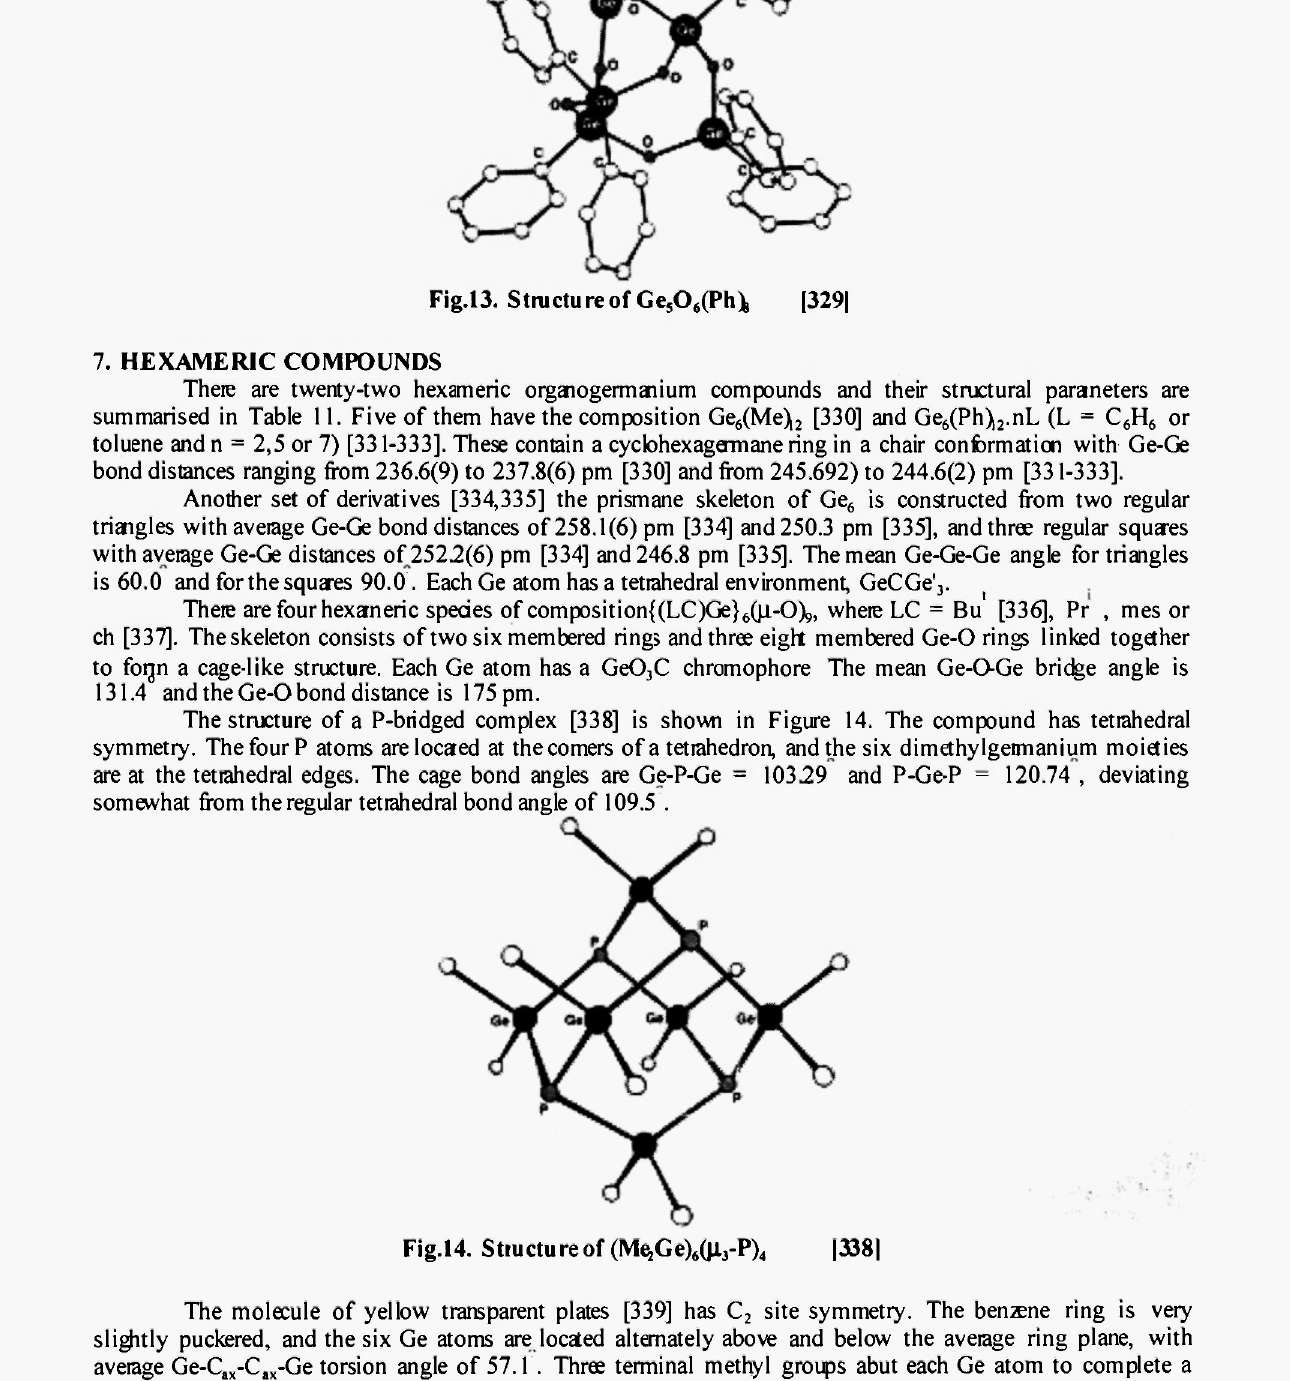
Fig.14. Structure of (M^Ge) 6 ^,-P) 4